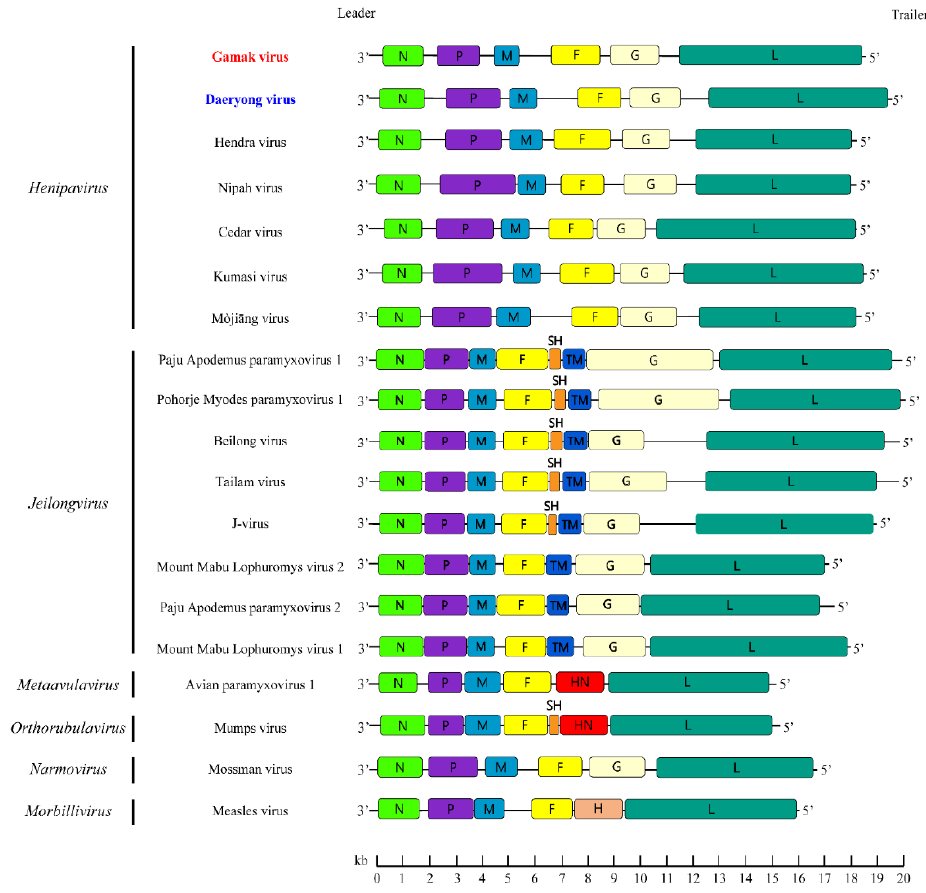
Figure 3. Organization of the genomes of the paramyxoviruses Gamak and Daeryong viruses, in individuals of Crocidura . The genomic configurations of related paramyxoviruses are shown. The genomes of paramyxoviruses comprise 6 to 8 coding regions: 3 ′ N-P-M-F-SH-TM-G, HN, or H-L 5 ′ . The colored boxes represent coding regions for each gene: N, yellow-green; P, purple; M, sky blue; F, yellow; SH, orange; TM, blue; G, light yellow; HN, red; H, Chilean pink; L, viridian. A scale bar of the length is shown under the genome structure. This figure was constructed by using Adobe Illustrator 2021 (http://www.adobe.com/products/illustrator.html, 3rd March 2021).